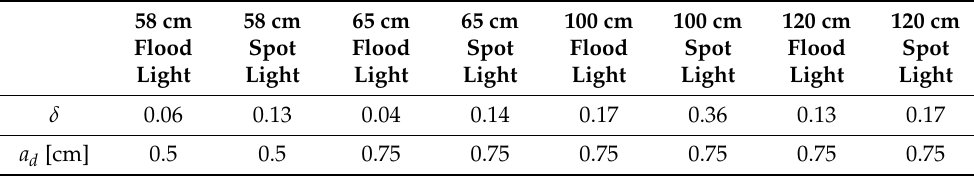
Table 4. Values of distance δ and corresponding detection threshold a d .